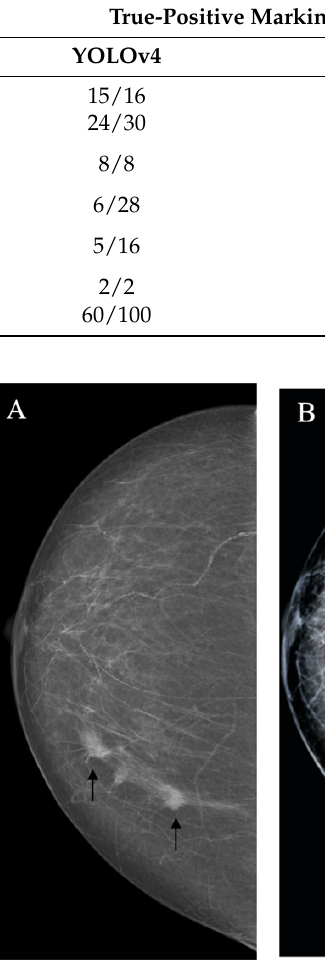
Figure 6. Round ‐ or oval ‐ shaped mass with clear border (arrow). ( A ): Source image; ( B ): YOLOv4 outcome; ( C ): NCA outcome. Partly visualized mass was selected to belong to a separate class because its charac ‐ teristics may become non ‐ typical due to the fact that the certain part of the lesion is out ‐ side the field of view. In this case, both approaches provided similar outcomes; however, the number of cases was too small for meaningful interpretation (Figure 7).